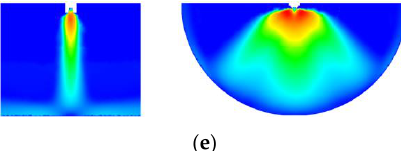
Figure 8. Contours of the spraying flow field velocity distribution. ( a ) Flat spraying flow field. ( b ) Spraying flow field of the busbar on the outer surface of the arc surface. ( c ) Circumferential spraying flow field on outer surface of the arc surface. ( d ) Spraying flow field of the busbar on the inner surface of the arc surface. ( e ) Circumferential spraying flow field on the inner surface of the arc surface. The lateral velocity and the longitudinal velocity near the wall affected the film formation area and the film formation thickness, respectively. The velocity distributions of each cross-section and longitudinal section near the wall are shown in Figure 9. There was a point where the velocities coincided in the figure. On the left side of the point, the velocity gradient was distributed along the cross-section, but the reverse velocity gradient was distributed along the longitudinal section; the right side was the opposite distribution. According to the above analysis, the near-wall flow field was divided into four regions according to the velocity intersection in Figure 9. As is shown in Figure 10, the velocity gradient in zone I was upward and inward, the velocity gradient in zone II was downward and inward, the velocity gradient was upward and outward in zone III, and the velocity gradient was downward and outward in zone IV.